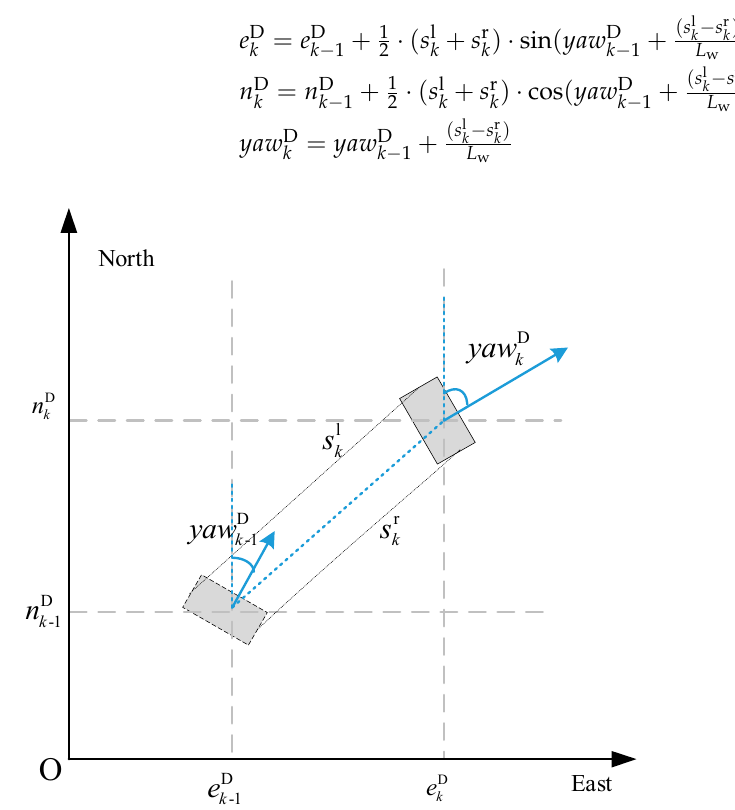
Figure 2. Working principle of DDE/INS system. However, the DDE system model is greatly affected if the road surface is not flat, which causes a large error in the mileage calculation. In order to improve the navigation performance of the auxiliary sensor system and the credibility of the ACNA algorithm, the DDE system model is optimized by tightly coupling the yaw angle yaw I and the height ∆ u I calculated by INS, as shown in the following formula: